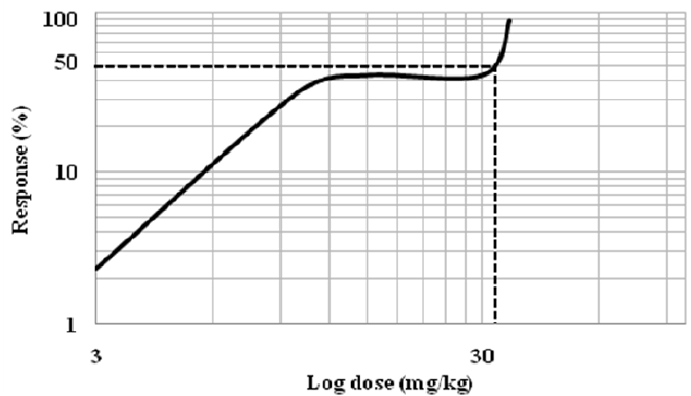
Figure 5. The determination of effective dose 50 (ED curves of antinociceptive effect of mitragynine in a hot plate test. The effect of mitragynine was assessed every 30 min during the total experiment period (120